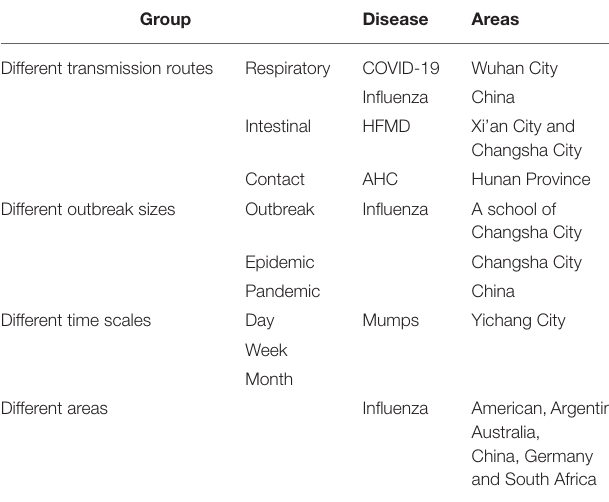
TABLE 1 | Disease types and areas at different levels.